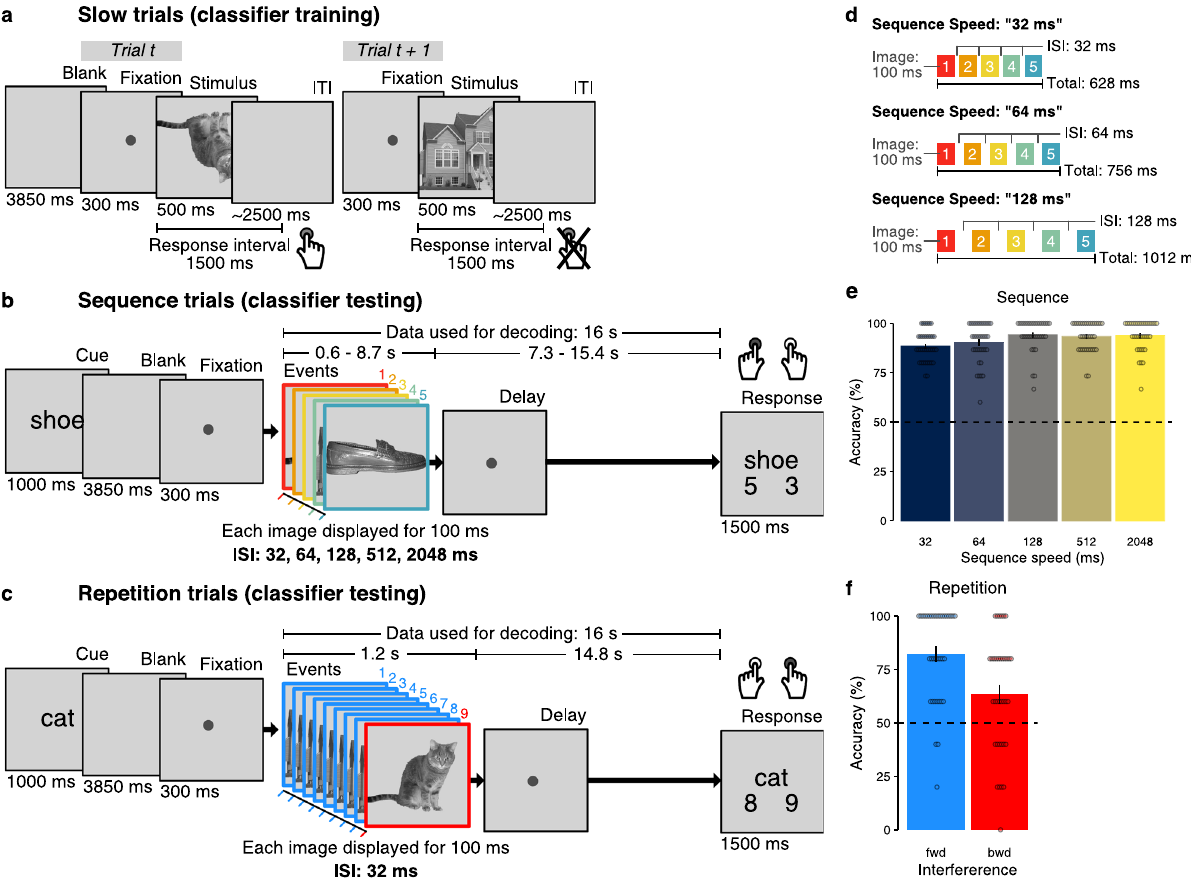
Fig. 1 Task design and behavioral performance. a On slow trials, individual images were presented and inter-trial intervals (ITIs) were 2.5 s on average. Participants were instructed to detect upside-down visual stimuli (20% of trials) but not respond to upright pictures. Classi fi er training was performed on fMRI data from correct upright trials only. b Sequence trials contained fi ve unique visual images, separated by fi ve levels of inter-stimulus intervals (ISIs) between 32 and 2048 ms. c Repetition trials were always fast (32 ms ISI) and contained two visual images of which either the fi rst or the second was repeated eight times (causing backward and forward interference, respectively). In both task conditions, participants were asked to detect the serial position of a cued target stimulus in a sequence and select the correct answer after a delay period without visual input. One sequence or repetition trial came after fi ve slow trials. fMRI analyses focused on the time from sequence onset to the end of the delay period (16 s ≈ 13 TRs, 1 TR = 1.25 s). d Illustration of the three fastest sequence speed conditions of 32, 64, and 128 ms ISI between images. e Mean behavioral accuracy in sequence trials (in %) as a function of sequence speed (ISI, in ms; N = 36, t s ≥ 23.78, p s < 0.001, d s ≥ 3.96, linear mixed effects (LME) model and fi ve one-sided one-sample t